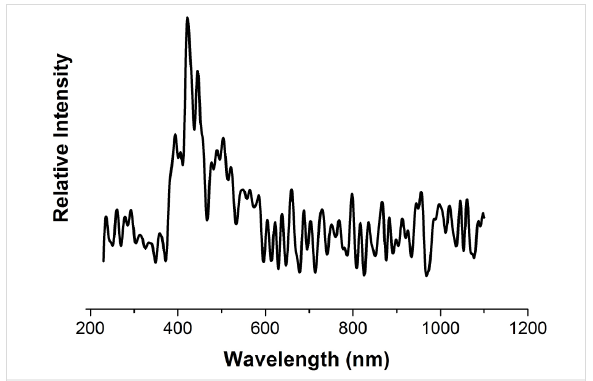
Figure 14: The fluorescence spectrum of an intercalating solution of titanium polyhydroxo complexes.